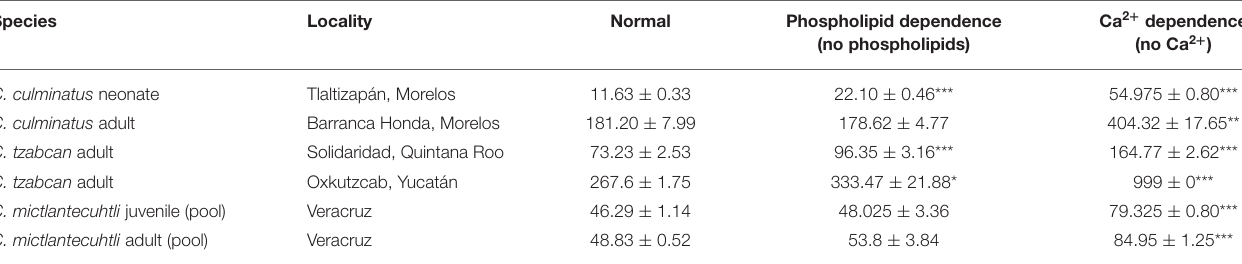
TABLE 3 | Cofactor dependence tests for six representative venoms ( C. culminatus , C. tzabcan , and C. mictlantecuhtli ) incubated with human plasma.